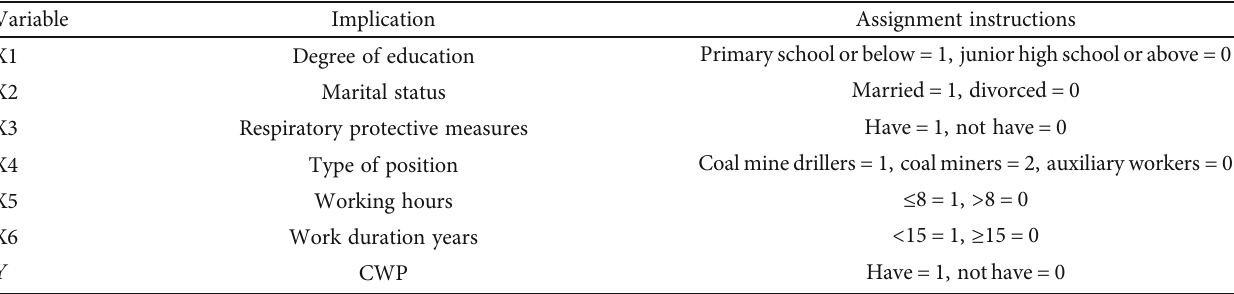
Table 5: Generalized linear models analyze the assignment